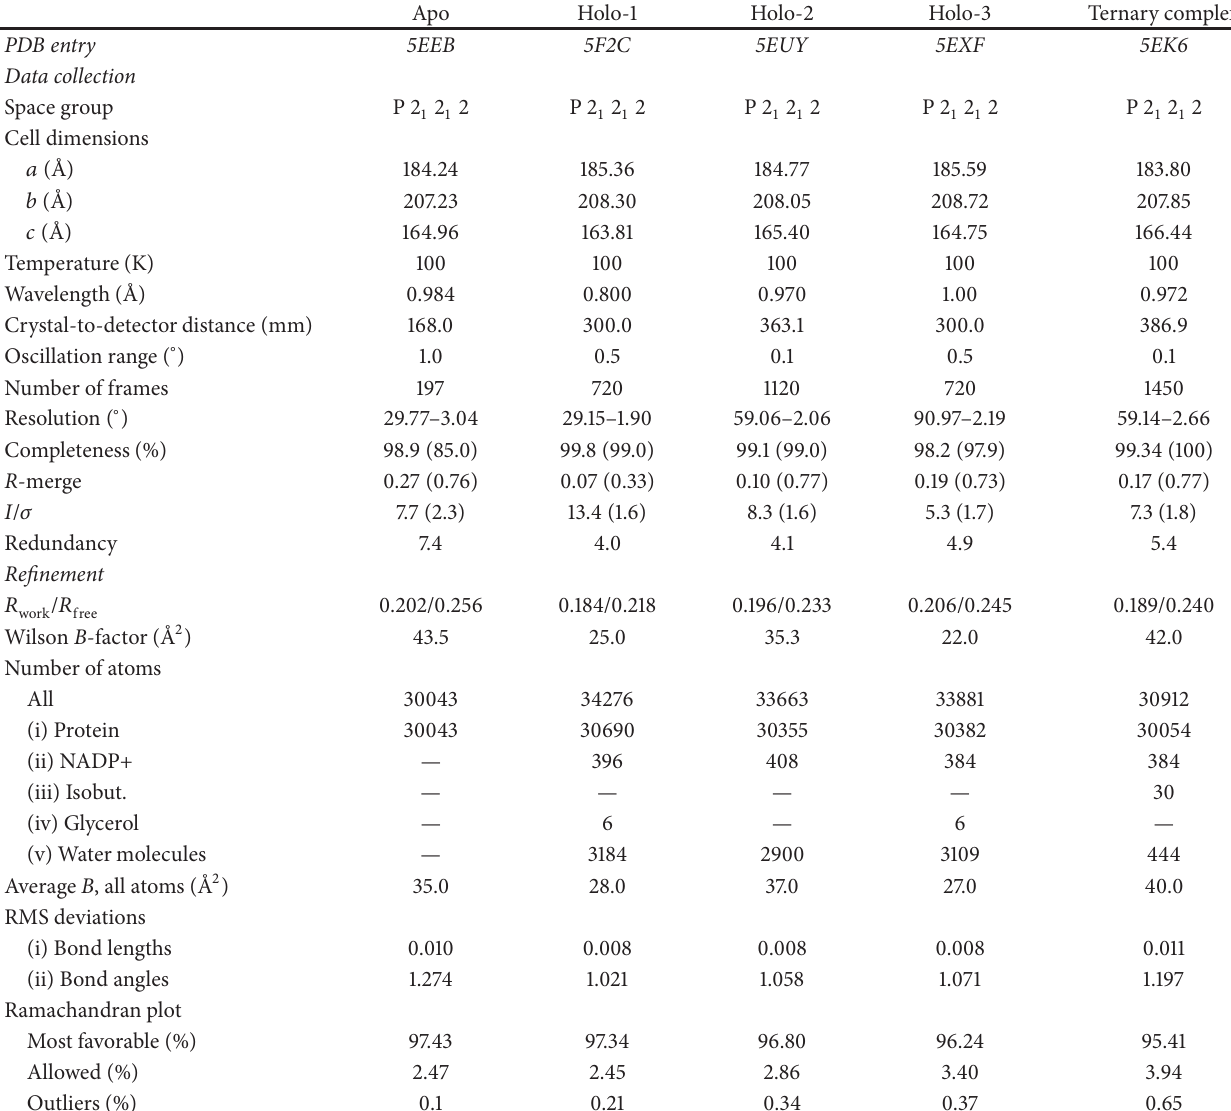
Table 2: Data collection and refinement statistics. Values in parentheses are for the highest resolution